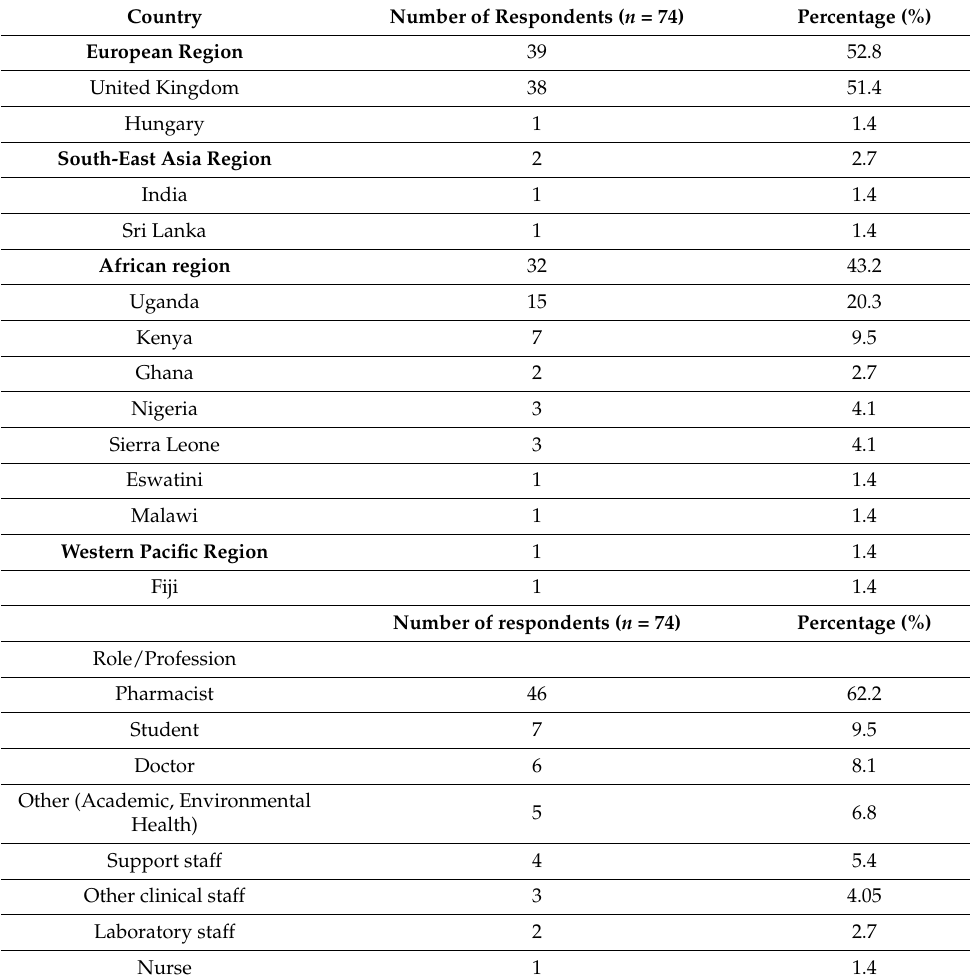
Table 2. Demographics of respondents (players’